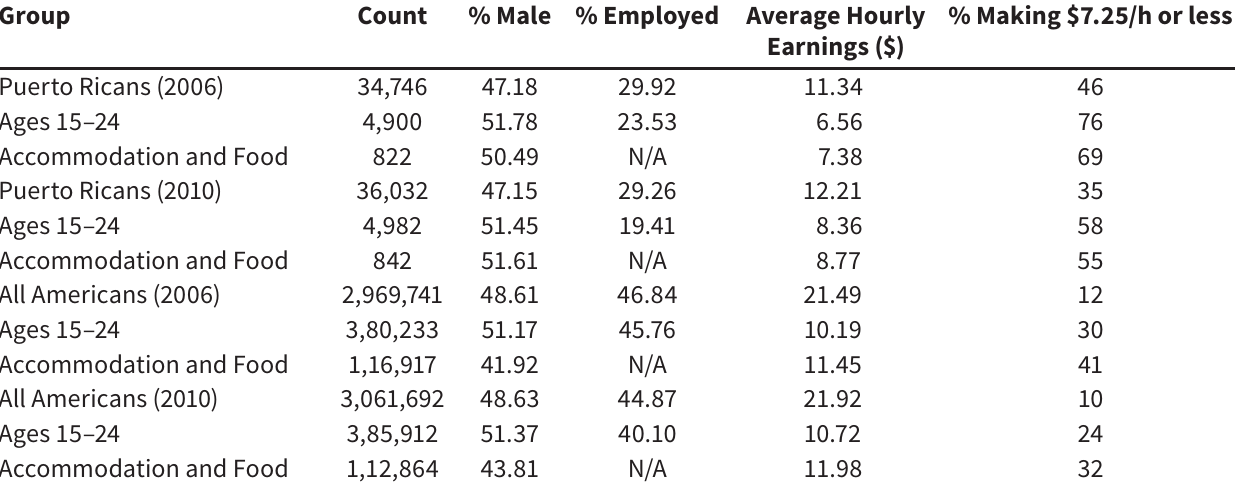
Characteristics of Puerto Rican